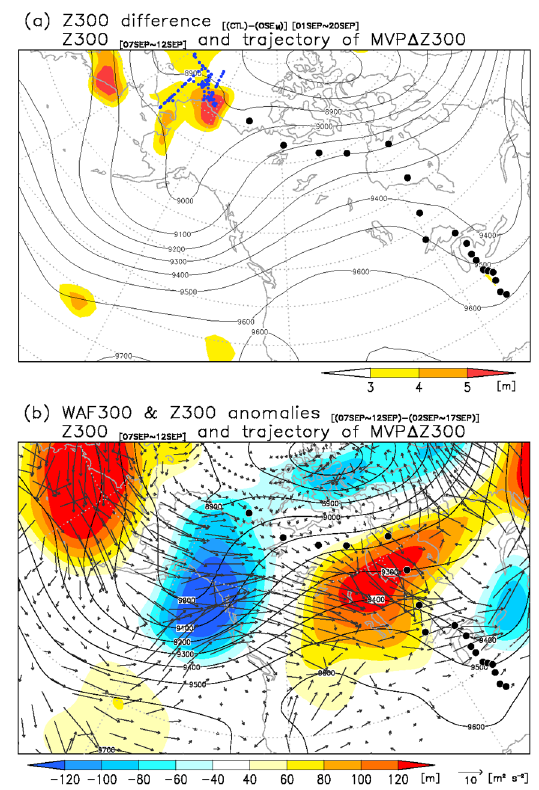
Figure 6. ( a ) Differences between forecast using the PrepBUFR global observation datasets (CTL) and forecast using the CTL dataset with radiosonde observations from RV Mirai removed (OSE M ) in mean analysis of geopotential height at 300 hPa (Z300; shaded; unit: m) between 1 and 21 September 2017 and mean analysis of Z300 (contour; unit: m) between 7 and 12 September 2017; blue dots indicate locations of radiosonde observations conducted from RV Mirai. ( b ) Z300 anomaly (shaded; unit: m) with wave activity flux at 300 hPa (vector; unit: m 2 s − 2 ) calculated as difference between average over 5-day forecast (7–12 September 2017) and average over 15-day (2–17 September 2017); black contour indicates mean Z300 (unit: m) over 5-day forecast (7–12 September 2017); black dots indicate trajectories of maximum positive values of the difference between CTL and OSE M forecasts in Z300 ensemble mean. See text for details.